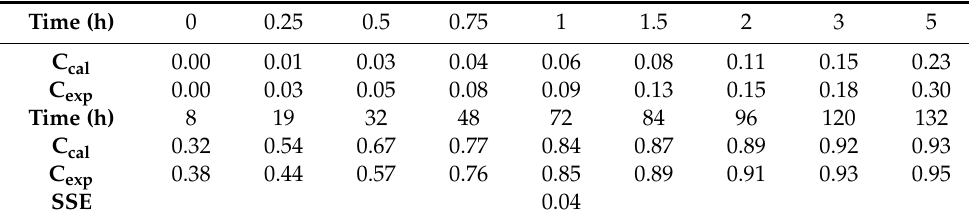
Table 3. The SSE of HSDM models.